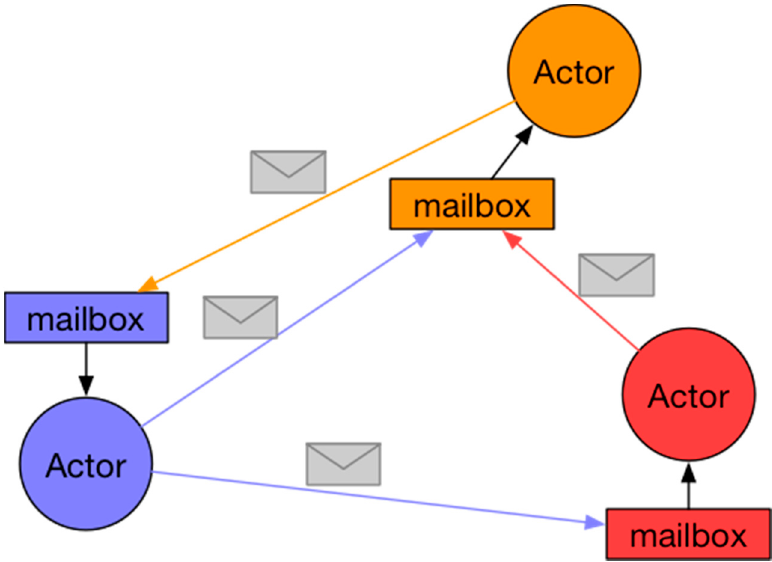
Figure 4. Representation of the messaging system in the Actor Model.